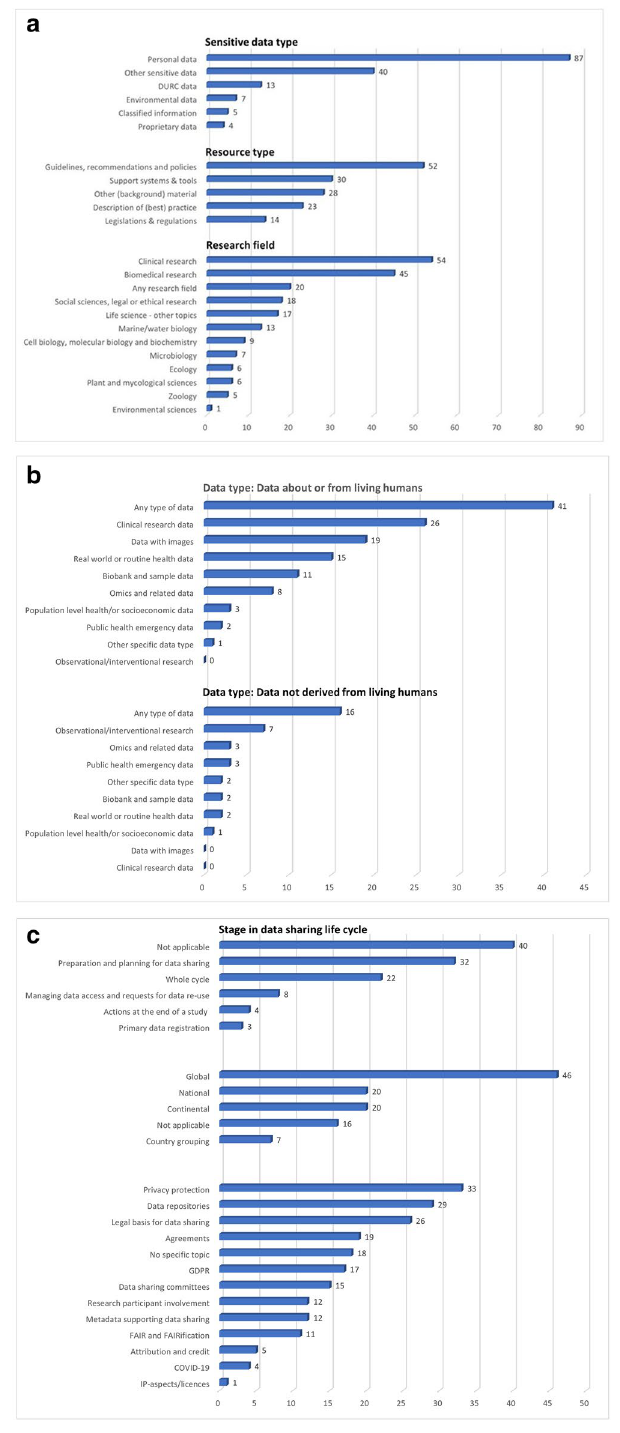
Figure 2. ( a ) Number of times a pre-listed tag was used for the categories « sensitive data type », « resource type » and « research field » (version 3) ( b ) Number of times a pre-listed tag was used for the category « data type » (version 3) ( c ) Number of times a pre-listed tag was used for the categories “stage in data sharing life- cycle”, “geographical scope” and “specific topics” (version